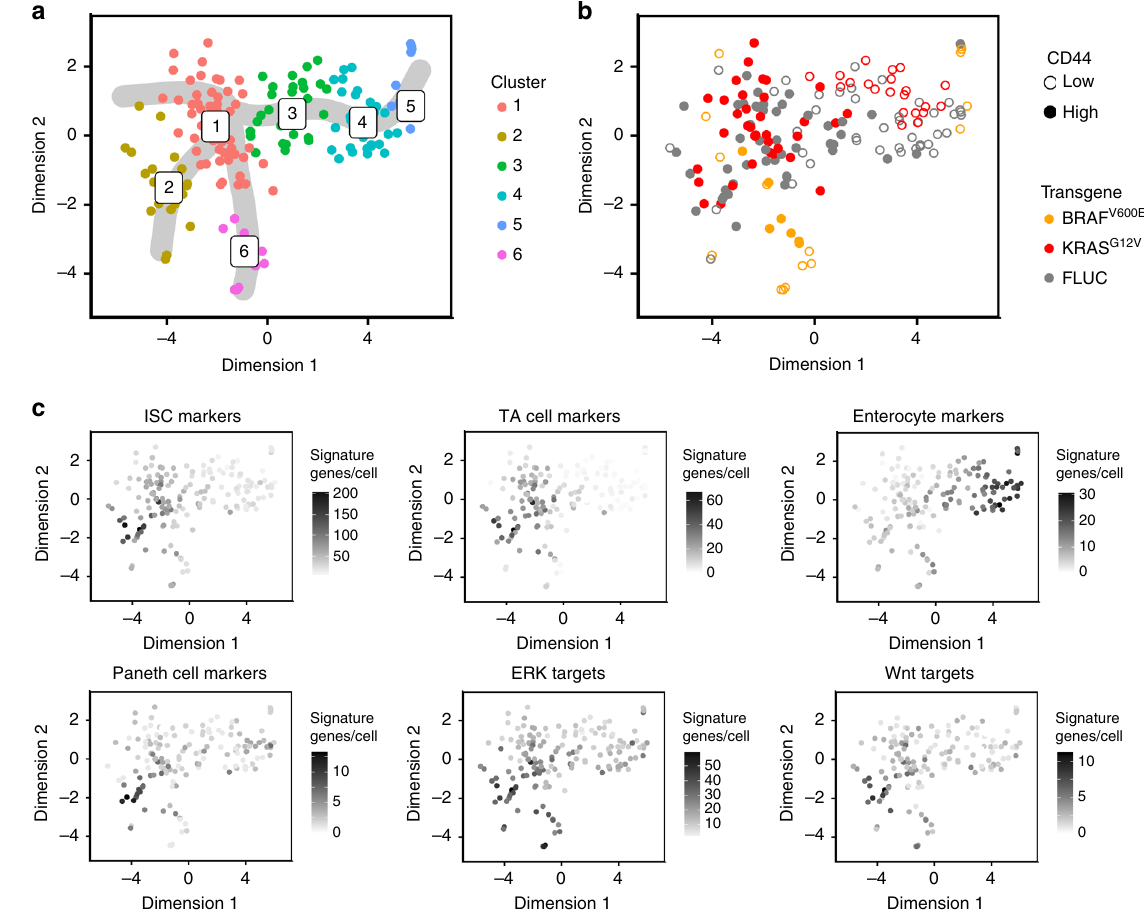
Fig. 3 Differential effects of BRAF V600E or KRAS G12V on gene expression and intestinal cell hierarchies. All panels: t-SNE visualisations and clustering of organoid single-cell transcriptomes clustered with k-means, 24 h after induction of FLUC control, BRAF V600E or KRAS G12V transgenes. a Colour code for six k-means clusters, and inferred differentiation trajectories starting at cluster 1 shown as grey overlay. b Colour code for transgene and CD44 positivity, as inferred from fl ow cytometry. CD44 positivity was used to direct cell selection, and thus relative fractions of CD44-high and -low cells are not representative. For CD44 status of the cell populations, see Supplementary Fig. 2. c Mapping of cell- and pathway-speci fi c differentiation signatures. Numbers of signature genes detected are given per single-cell